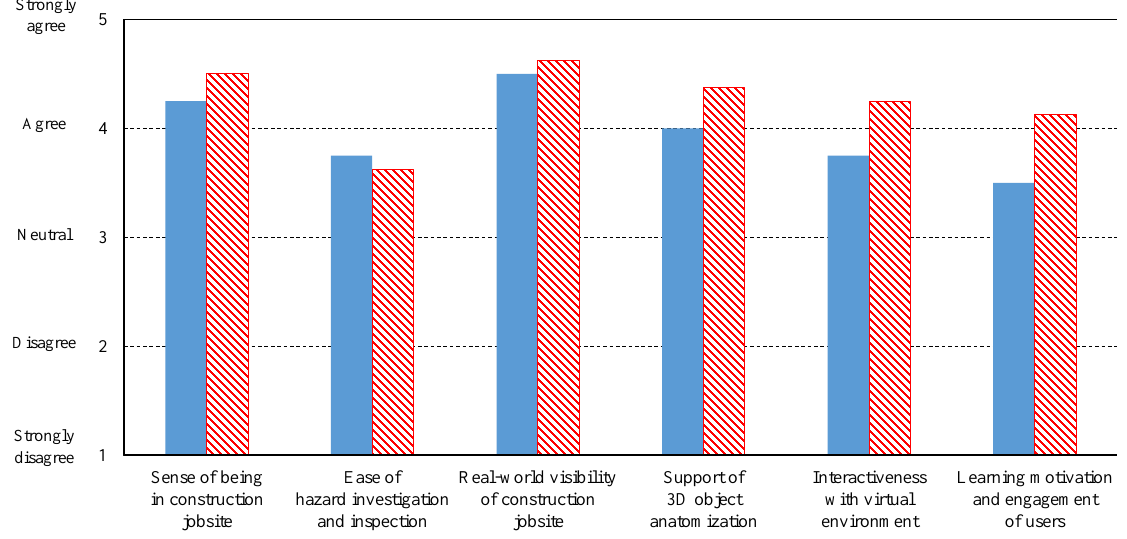
Figure 6. Usability